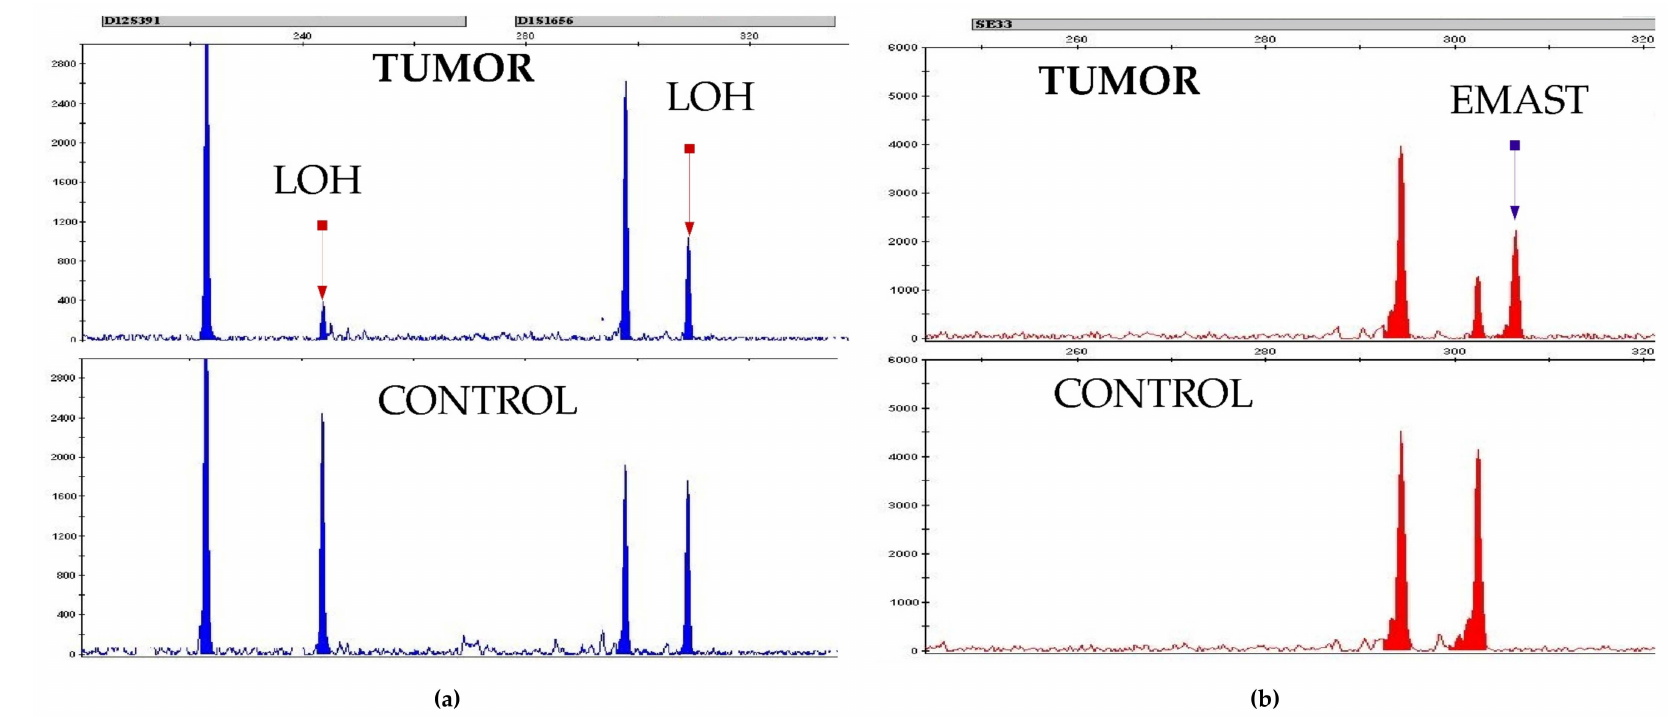
Figure 2. LOH and EMAST patterns in STR profiles of PMBCL patients: ( a ) two LOH aberrations in tumor DNA; ( b ) EMAST in tumor